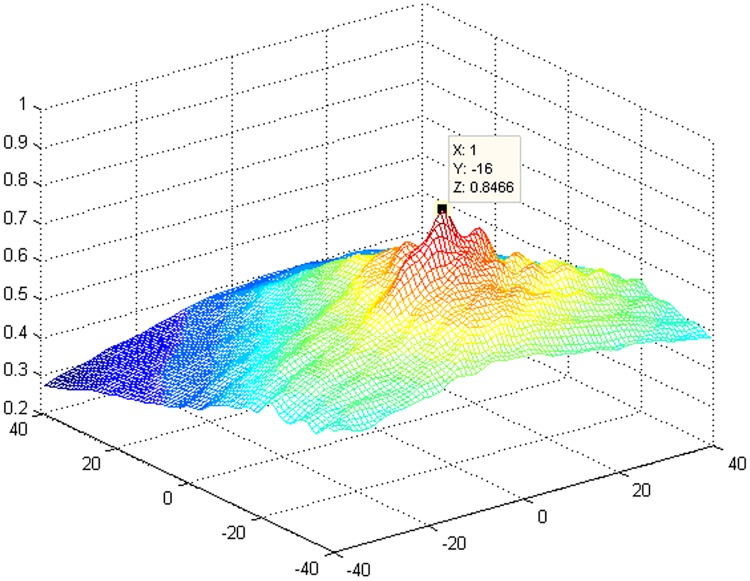
Three-dimensional diagram of the correlation coefficients between cutpb and all cutzb images.